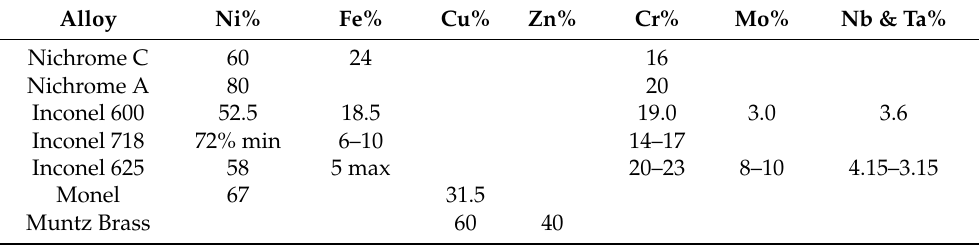
Table 1. Compositions of various alloys used (weight